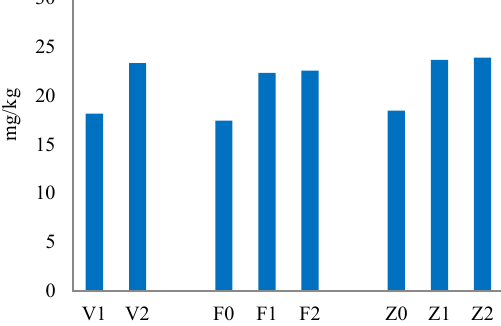
Fig. 7. Mean comparison of Variety, Iron and Zinc simple effects on Zn